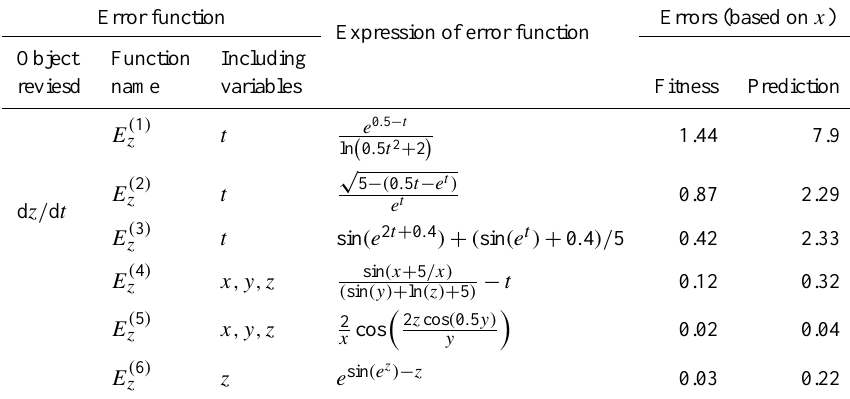
Table 4. Error functions and errors of the equations obtained by EM (for variable z ). Error function Errors (based on x Expression of error function